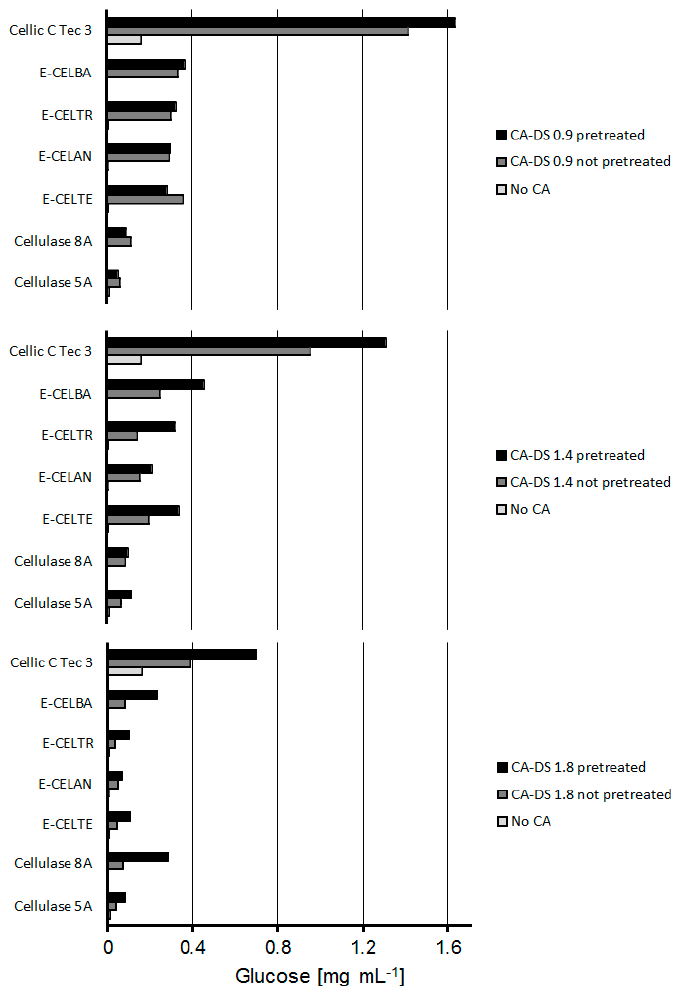
Figure 5. HPLC results of synergistic cellulose acetate degradation by cellulases. Substrates were pretreated with esterase AXE 55. Samples without cellulose acetate were examined to estimate the glucose content of the used enzyme formulations.